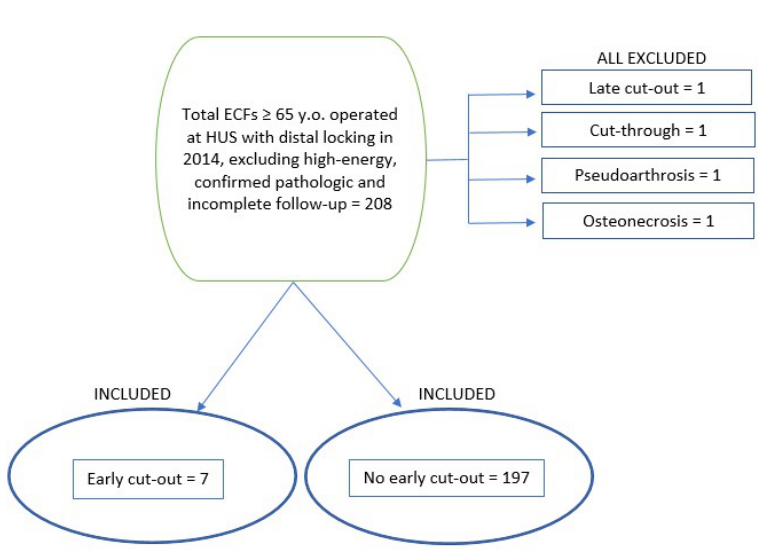
Figure 1. Organization chart (ECF, extracapsular fracture; HUS, Hospital Universitario de Salamanca; Sx., surgery.).